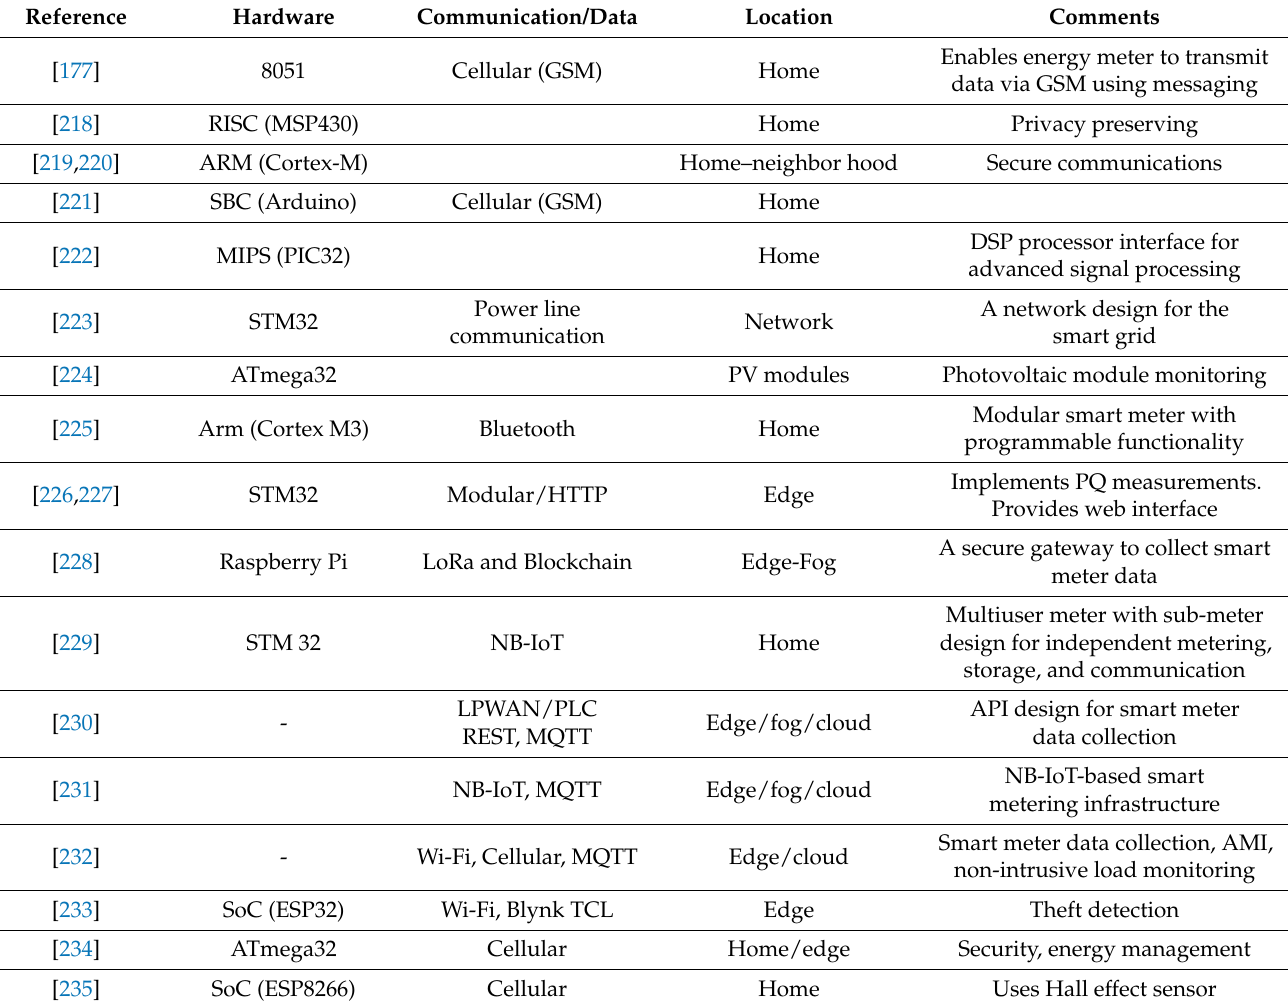
Table 9. Review of different implementations from the perspective of hardware, software, and